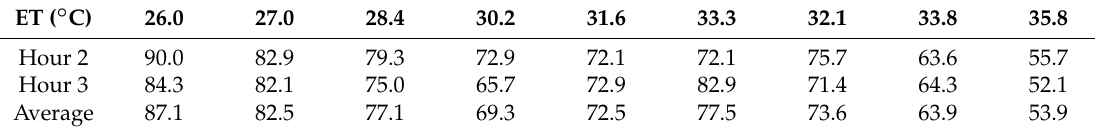
Table 2. Production data digitised from Figure 2 of Nag and Nag (1992)